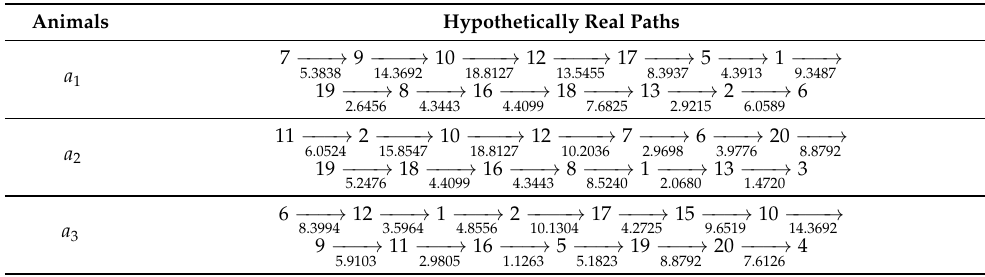
Table 4. The hypothetically real foraging paths for animal 1, 2 and 3. These results, which are based on simulated data, represent the real foraging paths for each